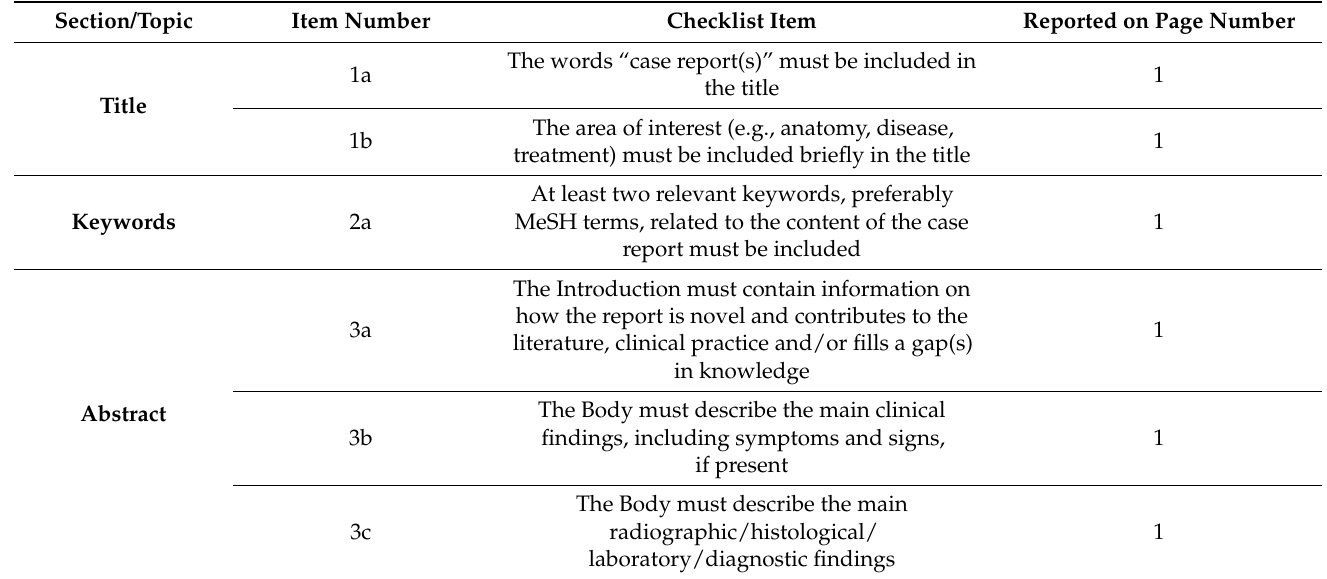
Table A1. PRICE 2020 checklist of the present case